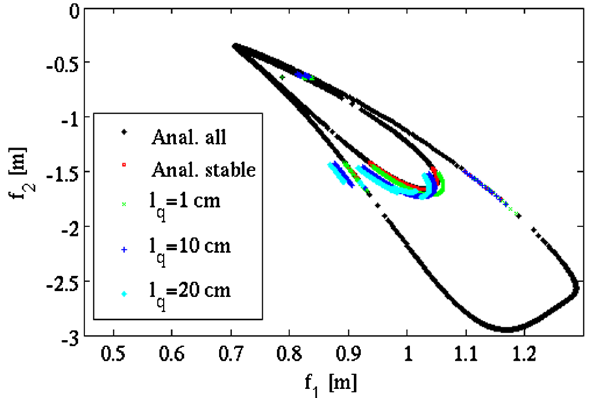
FIG. 7. Comparison between the analytical solution and MADX simulations. The analytical solutions are presented in black, the solutions satisfying the stability requirements in red and the ¼ 1 cm in results from MADX for different quadrupole lengths: l q ¼ 10 cm in blue, and l ¼ 20 cm in green, l q q